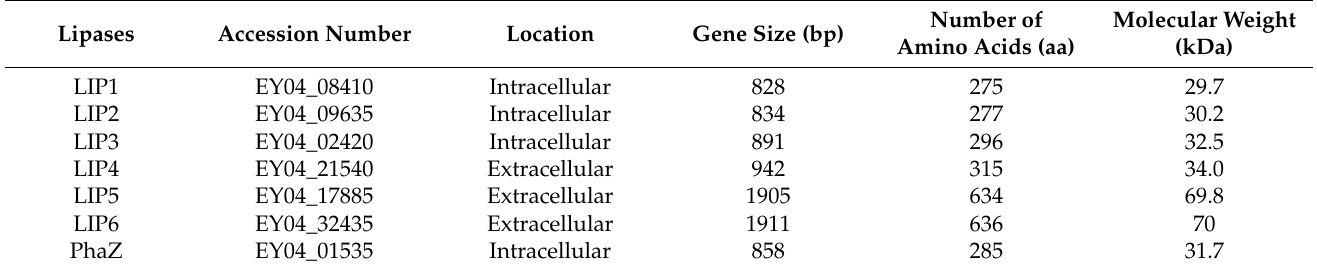
Table 1. Putative lipases and PhaZ present in the genome of Pseudomonas chlororaphis